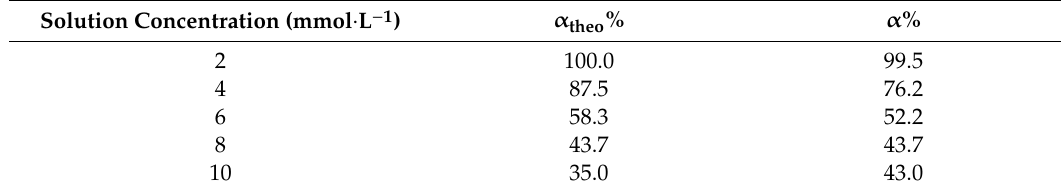
2. Theoretical ( α theo ) and experimental ( α ) Eu 3 + ion uptakes by poly(VDF 0.7 - ter -VPA 0.1 - ter -VTEOS 0.2 ) terpolymer ( HCP 20 ) in various Eu 3 + concentrations.